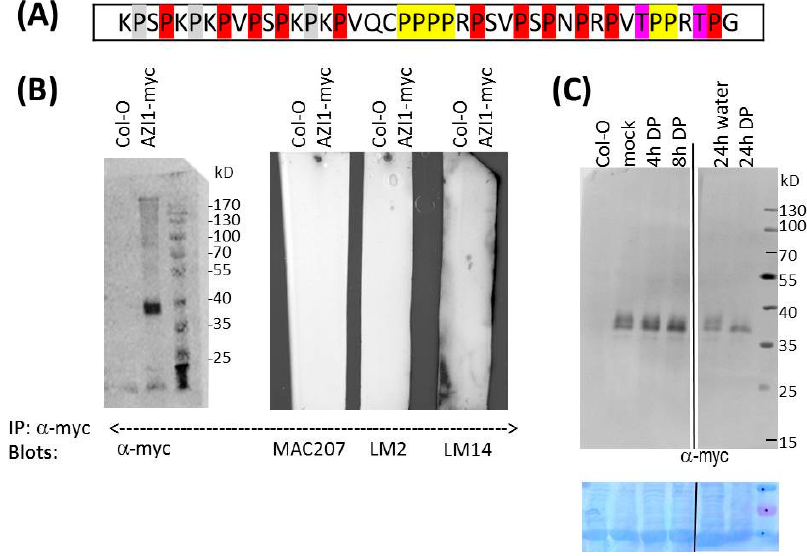
Figure 3. AZI1 glycosylation—theoretical considerations and experimental approaches. ( A ) Potential glycomodules in the AZI1 Pro-rich region (residue 31 to 72) according to the Hyp contiguity hypothesis [32] and the assumption of general Pro-hydroxylation, unless excluded by Rule 1; Rule 1: Lys-Pro, Leu-Pro, Tyr-Pro are never hydroxylated (highlighted in grey) but Pro-Val is always hydroxylated (in case of conflict we decided to prioritize the latter). Rule 2: Contiguous Hyp is arabinosylated (highighted yellow). Rule 3: discontiguous Hyp is AG II modified (highlighted red). Under the applied rules, T66E or T70E substitutions (highlighted in purple, see Figure 1) permits prolyl hydroxylation and sugar attachment. In summary, the assumed modifications are: arabinosylation at six positions (yellow) and galactosylation at up to eleven positions (red). The glycan size cannot be predicted and for each AG glycan might range in size from single galactosyl residues to high molecular weight AG II polysaccharides [27]. AZI1 molecules carrying some of the theoretically possible modifications would easily exceed the predicted peptide mass; ( B ) Glycan-directed antibodies do not recognise AZI1-myc purified from plants. Protein extracts from 3-week-old Arabidopsis Col-0 wild type or AZI1-myc overexpressing plants were immunoprecipitated with mouse anti-myc antibody and proteinA-coupled magnetic beads. Captured proteins were analysed by SDS-PAGE and immunoblot detection using the indicated antibodies from rabbit. AZI1-myc can be successfully immunoprecipitated ( left ), but the protein is not recognised by anti-glycan-directed antibodies ( right ). MYC207, LM2 and LM14 did recognise positive control proteins (not shown); ( C ) Inhibition of prolyl hydroxylation alters AZI1 gel migration. Two independent experiments are shown. Left panel: 14-day-old Arabidopsis seedlings constitutively expressing a AZI1-myc transgene were incubated in standard medium supplemented with 100 µ M 2,2-dipyridyl. Mock-treatment was for 4 h; Right panel: 10-day-old seedlings were incubated in tap water with or without 100 µ M 2,2-dipyridyl for 24 h. Proteins were extracted, separated by SDS-PAGE and detected with anti-myc antibody. Protein loading was documented by staining of the PVDF membrane with Coomassie brilliant blue ( bottom ).